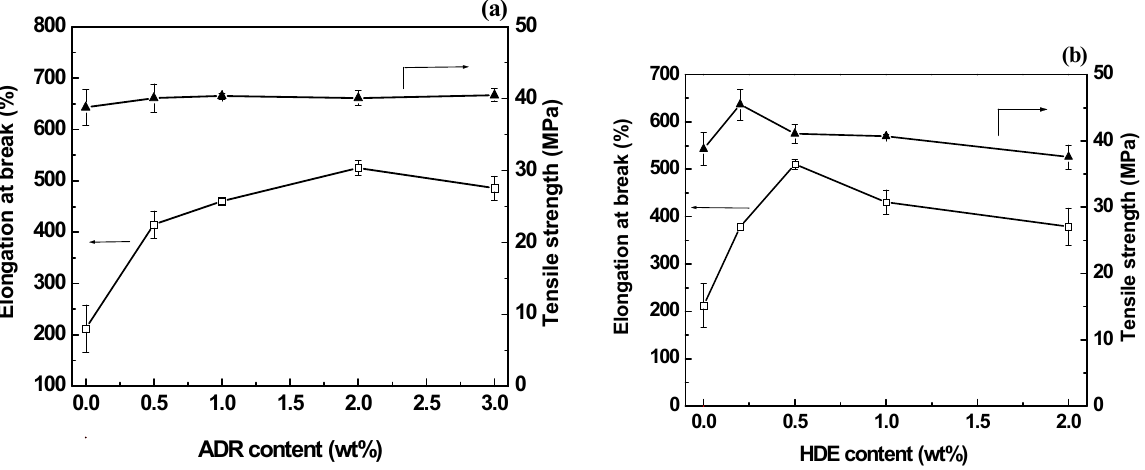
Figure 3. Tensile properties of the PLA/PBAT blends as a function of ( a ) ADR content and ( b ) HDE